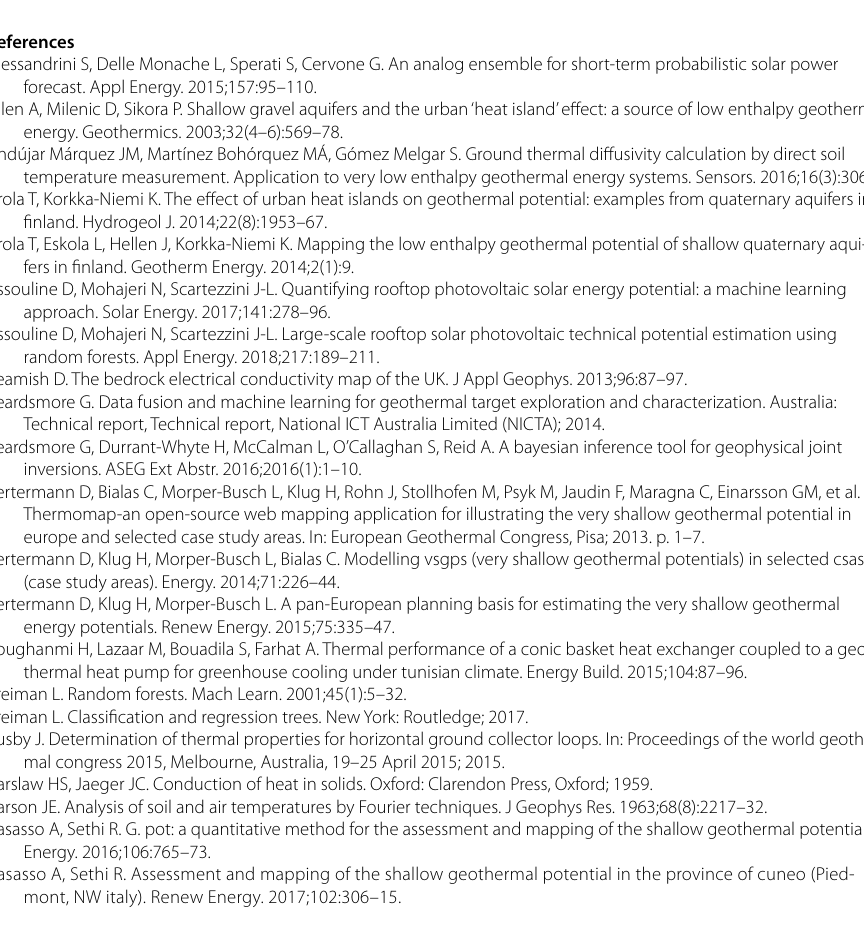
(–) signifies no unit. (var. unit) signifies that the unit is defined by the quantity of interest represented by the variable